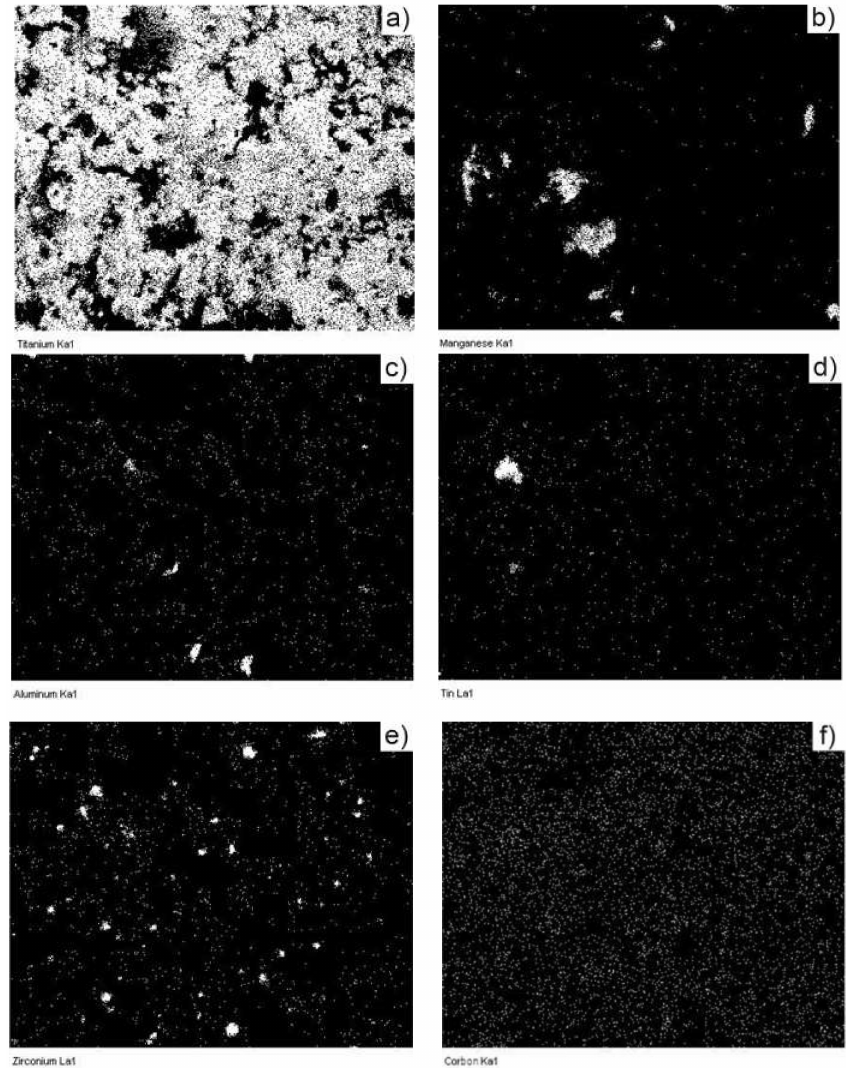
Figure 6. Elemental mapping evidencing the component’s dispersion in the mixture: ( a ) Ti; ( b ) Mn; ( c ) Al; ( d ) Sn; ( e ) Zr and ( f )